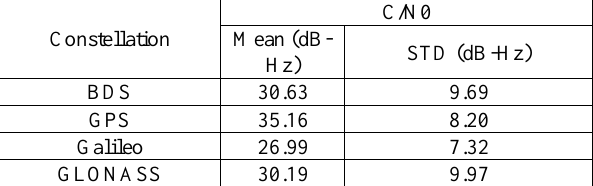
Table 2 . The mean values and standard deviations of C/N0 measurements of different